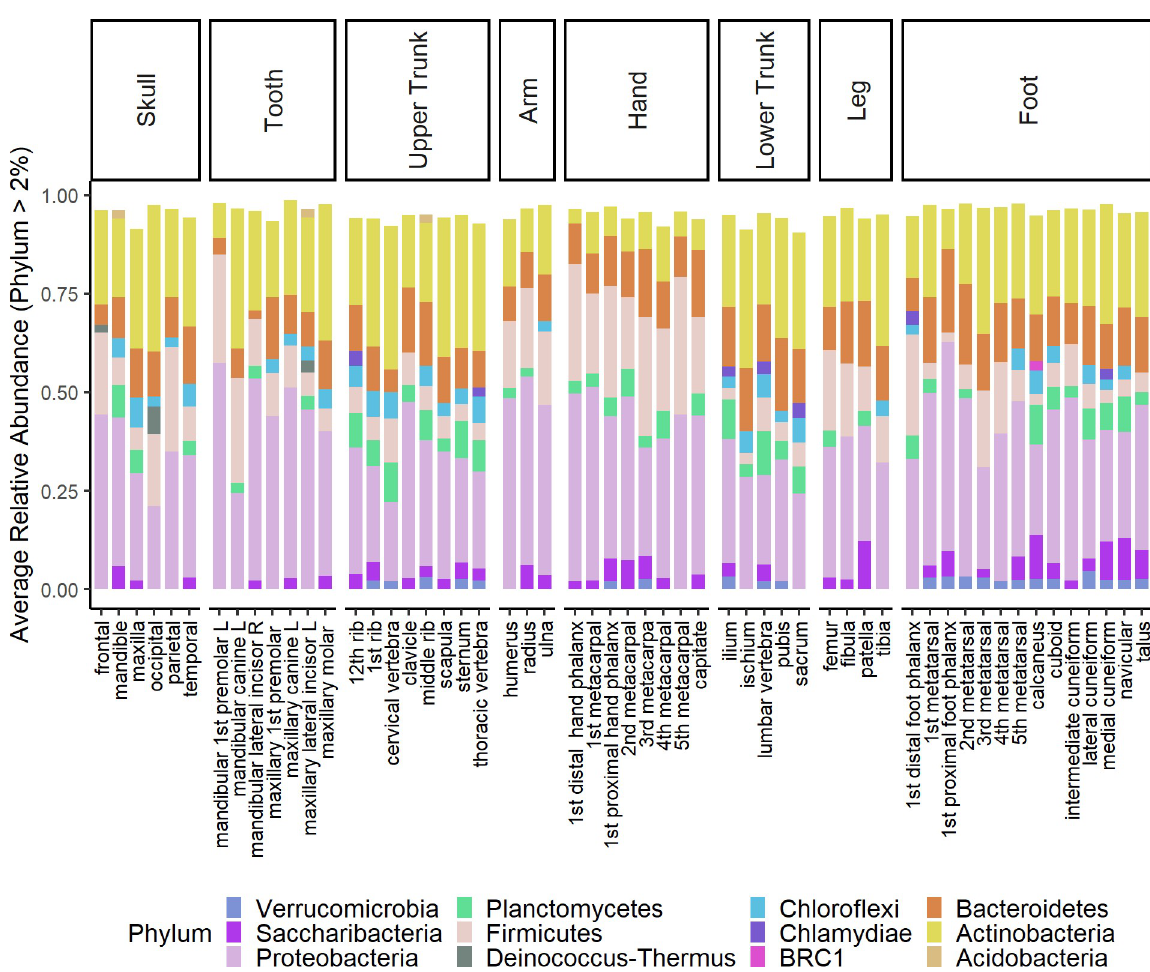
Fig 3. Bacterial phylum-level community membership. Mean relative abundances greater than 2% for all individuals combined. Bone phyla membership was averaged by bone type (n = 3), except in the navicular, occipital, and sternum (n = 2). Bacterial communities significantly differed by individual ( p = 0.001, F = 11.08, DF = 2) (Fig 4), body region ( p = 0.001, F = 3.99, DF = 7), human DNA concentration ( p = 0.02, DF = 3, F = 1.48), and cortical bone content ( p = 0.003, F = 1.28, DF = 5). There was a signifi- cant interaction between body region and individual ( p = 0.001, F = 2.70, DF = 14) and body region and cortical content ( p = 0.02, F = 1.23, DF = 4) (Fig 5). Heterogeneous multivariate dispersion was observed by individual ( p = 0.016), body region ( p = 0.001), and cortical cate- gory ( p = 0.001), but not human DNA ( p = 0.27); bacterial communities from individual A and C clustered more tightly compared with individual B (Fig 4). When examining individuals independently, body region remained significant (A, p = 0.001; B, p = 0.001; C, p = 0.001), while cortical content remained significant in individuals B and C (B, p = 0.003; C, p = 0.03) but not A ( p = 0.63). Diversity was significantly different by individual ( p < 0.01, DF = 2); individual A had the lowest diversity (mean = 30.0), while individual C had the greatest diversity (mean = 46.9) (S3 Fig). When each individual was considered independently, diversity also significantly differed by body region (A: p < 0.01, X 2 = 19.0, DF = 7; B: p < 0.0001, X 2 = 34.6, DF = 7); C: p < 0.001,